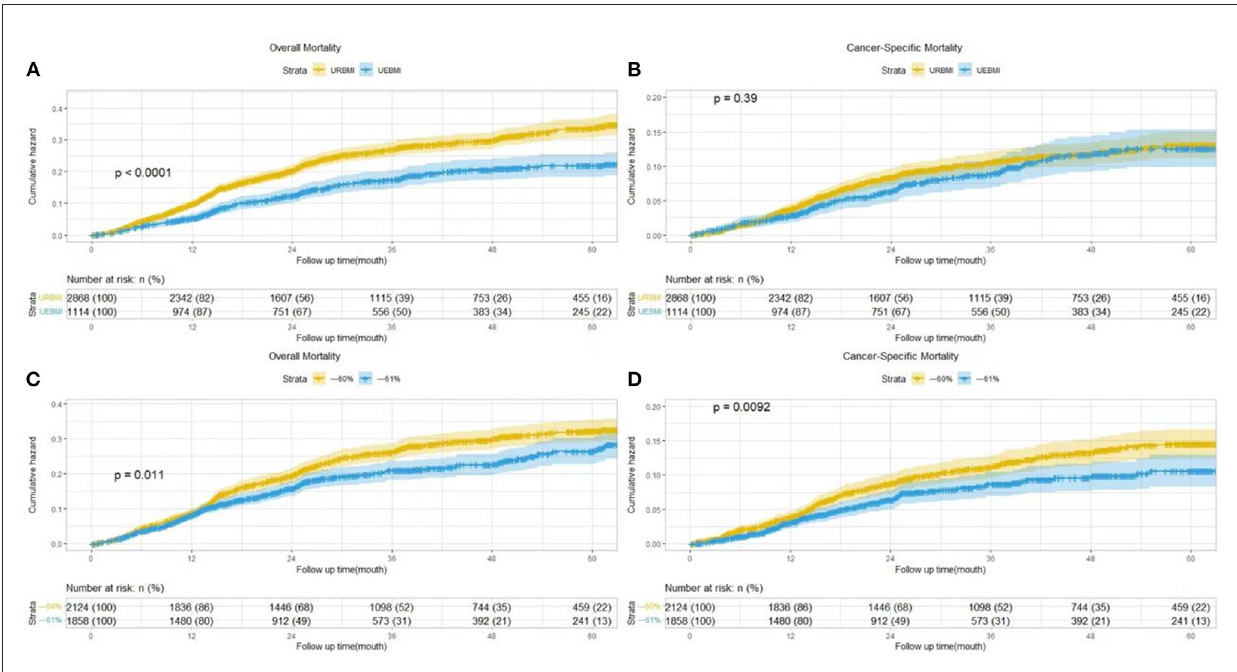
FIGURE1 Cumulative hazard of cervical cancer specific or overall mortality by insurance type (A, B) and self-paying rate (C, D) .